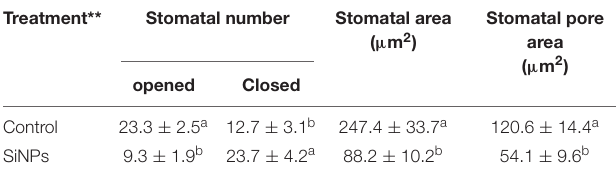
TABLE 7 | Effects of foliar application of SiNPs on the electrolyte leakage, lipid peroxidation, and contents of hydrogen peroxide and ascorbic acid in the leaves of grapevines infected with downy mildew at 15 days post the second spray.* Treatment**